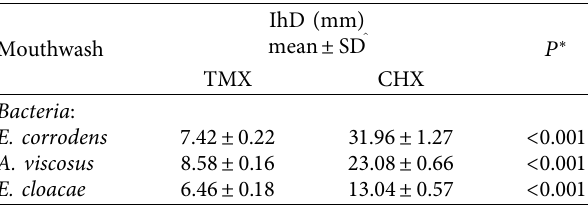
Figure 2: Te diference between inhibitory halo diameters of the E. corrodens , A. viscosus , and E. cloacae . Table 2: Efects of TMX and CHX on IhD of the three bacterial